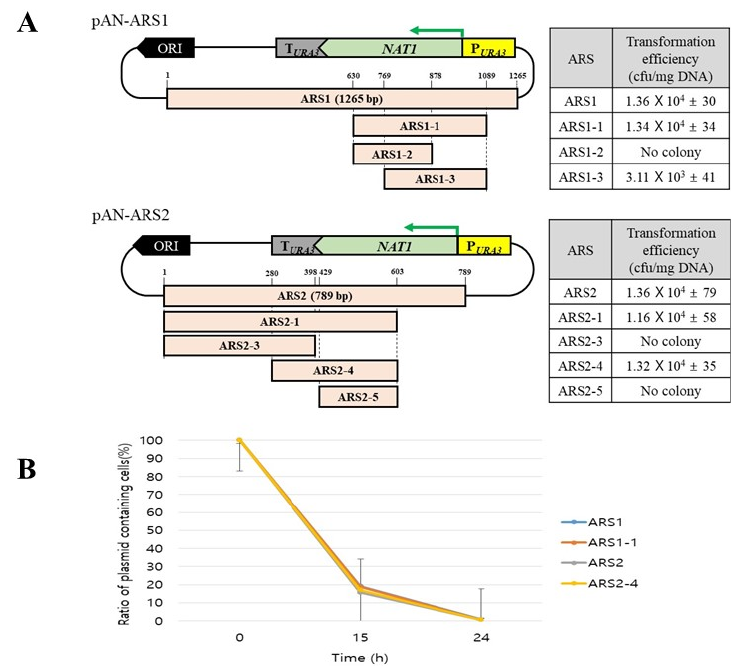
Figure 1. Determination of core domain of ARS1 and ARS2 and stability test of autonomously replicating sequence (ARS) plasmids. ( A ) Schematic diagram of ARS fragments and transformation e ffi ciency. ( B ) Stability of di ff erent ARS plasmids. Mean values and standard deviations of triplicates are shown.